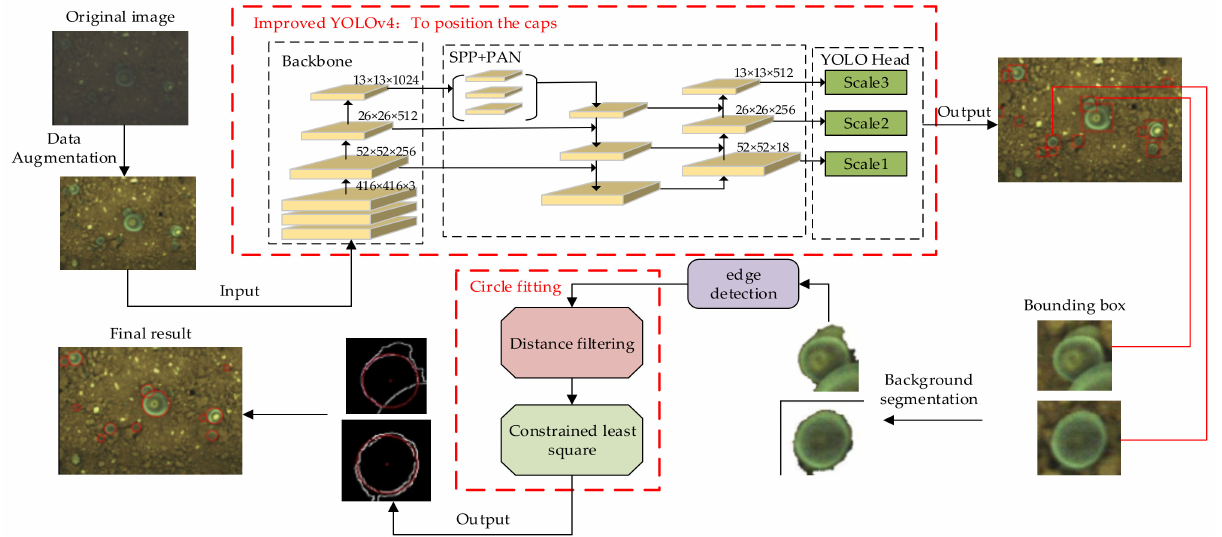
Figure 2. Pipelines of measuring algorithm for Oudemansiella raphanipies